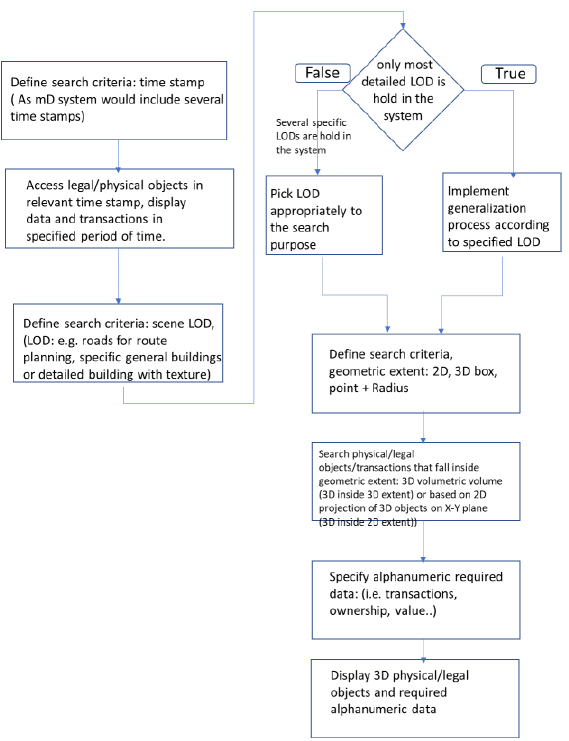
Figure 6. Illustrating a process of inserting a new volumetric spatial parcel in a